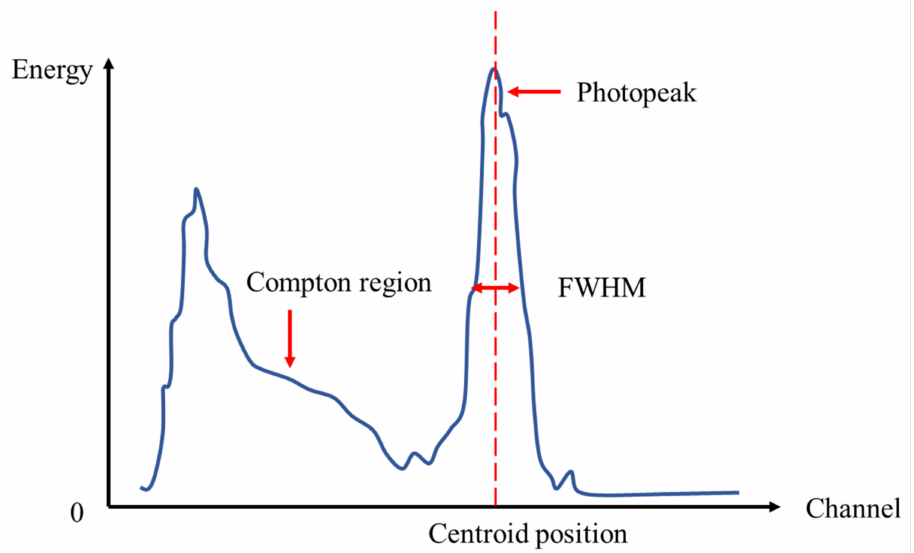
Figure 5. Photon energy spectrum measured by a scintillation